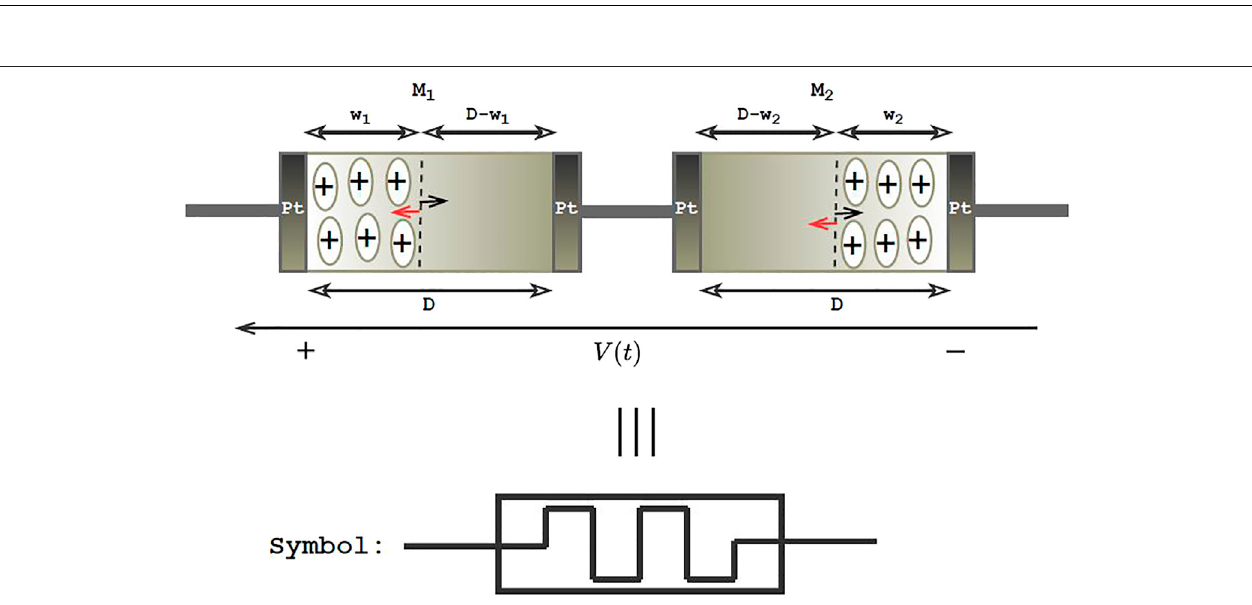
FIGURE 12 | Schematic of a memristor fuse formed by two TiO 2 memristors M 1 and M 2 . The positive spot signi fi es the positive oxygen vacancies, which serve as the higher conducting part of each memristors. w 1 and w 2 represent the instantaneous width of the doped region, meanwhile the black and red arrows describe the trendingexpansionandcontractionofthedopedregion,respectively.Hence,foranyinputvoltage,say V ( t ) ,anincreaseinthewidth w 1 correspondstoadecreasein w 2 and vice versa.